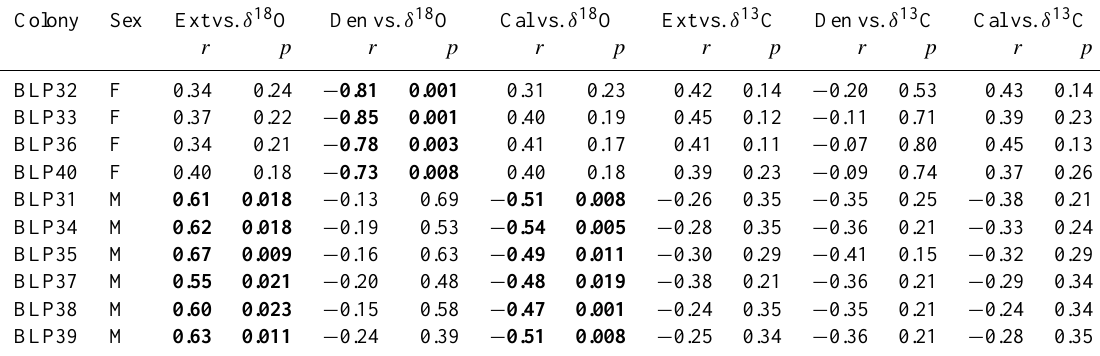
Table 5. Correlation coefficients between skeletal extension rate, skeletal density and calcification rate, and skeletal δ 18 O and δ 13 C of Porites panamensis colonies from Bahía de La Paz. Time period covered by correlations is from 1997 to 2009. Temporal resolution of data is annual. Bold numbers indicate significant ( p< 0 . 05)